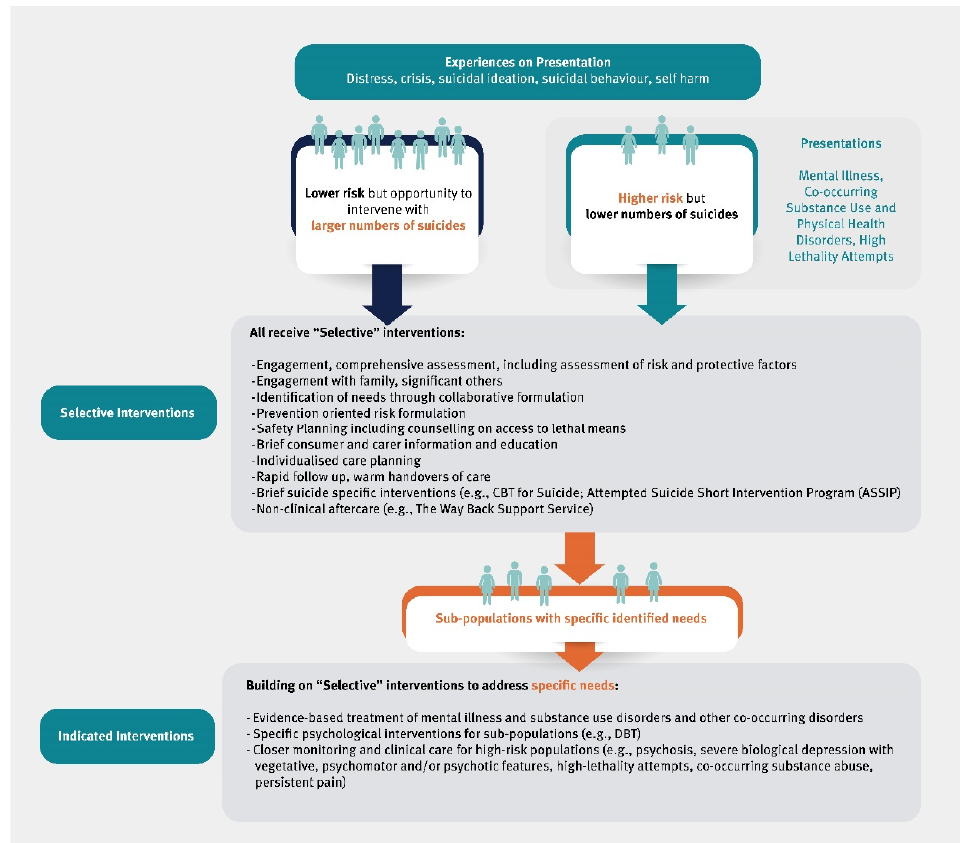
Figure 1. Selected and Indicated Populations and Interventions for Suicide Risk in Healthcare.